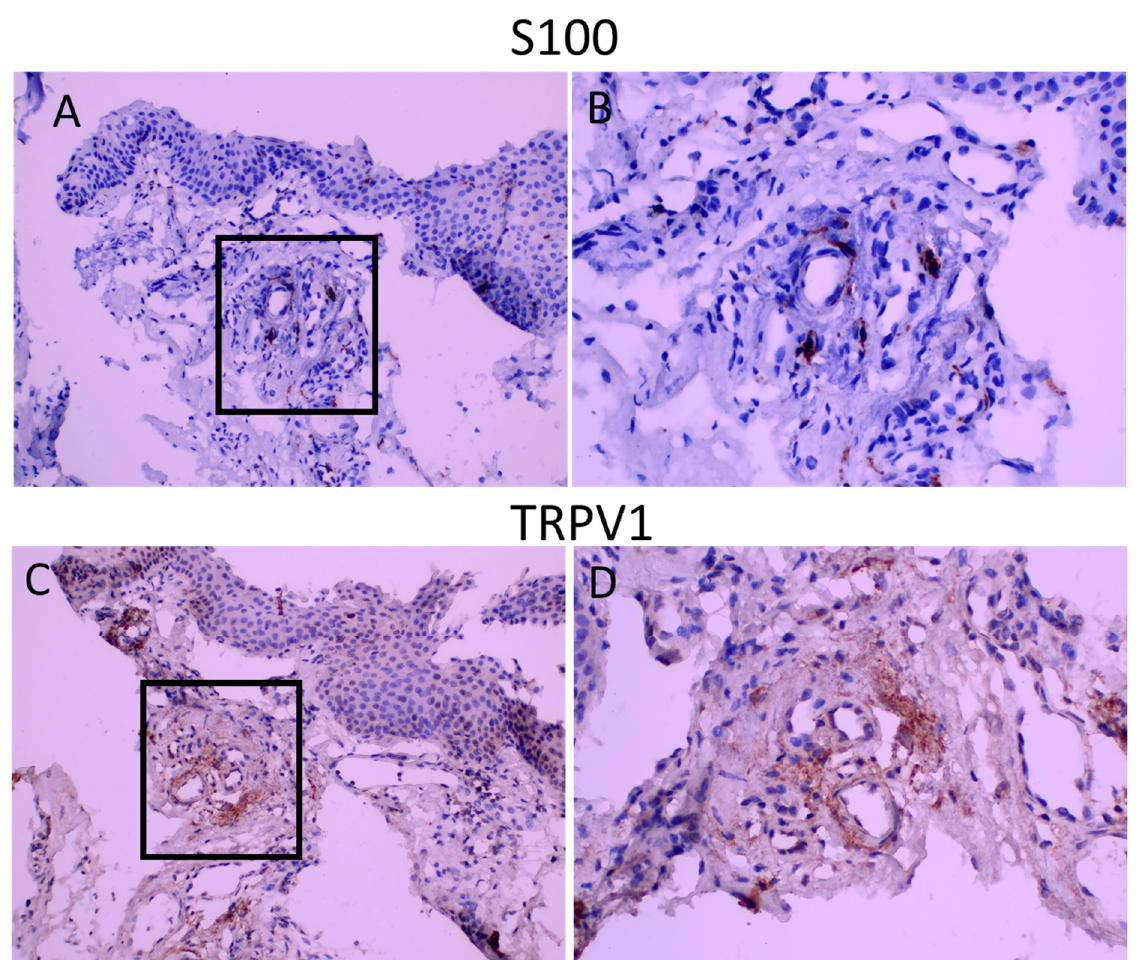
Figure 3. S100 and TRPV1 staining in consequent sections. Panel ( A ) and ( C ): appearance at 200 magnification. Panel ( B ) and ( D ): appearance of demarcated areas at 400 magnification. TRPV1 staining is diffuse and covers the areas of S100 immunoreactivity.